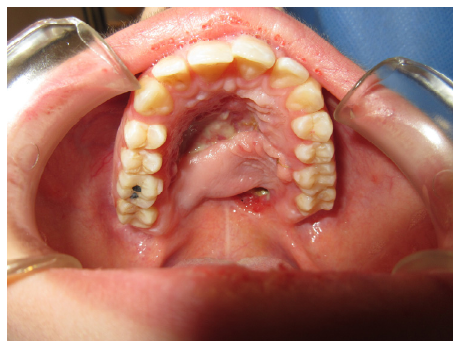
Figure 9. Day one before the application of the palatal plate.